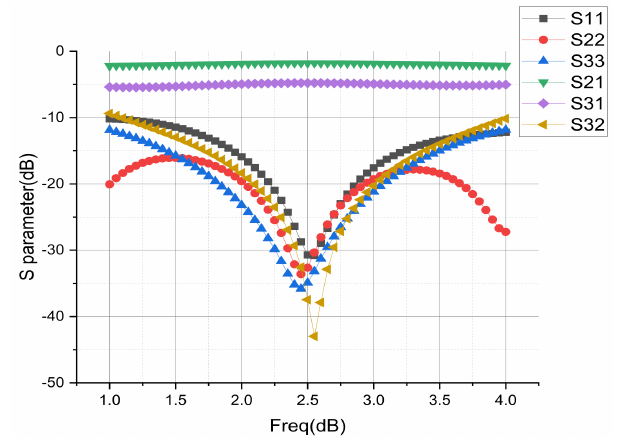
Figure 9. S parameter curve of the 2:1 Wilkinson power divider.